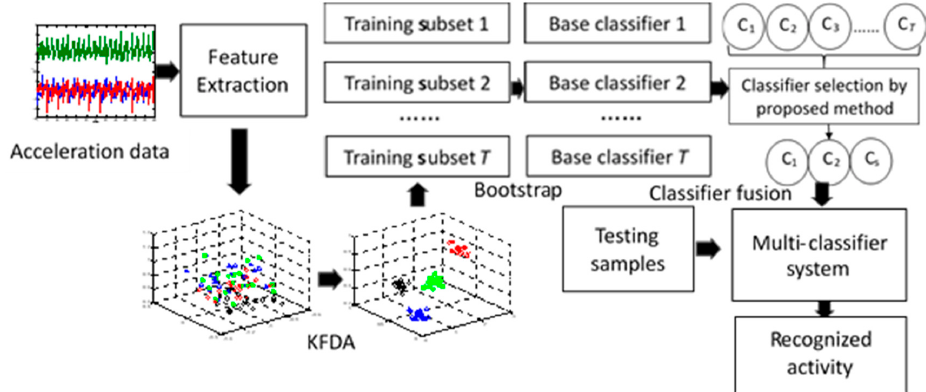
Figure 1. Work fl ow of the proposed activity recognition approach. Figure 1. Workflow of the proposed activity recognition